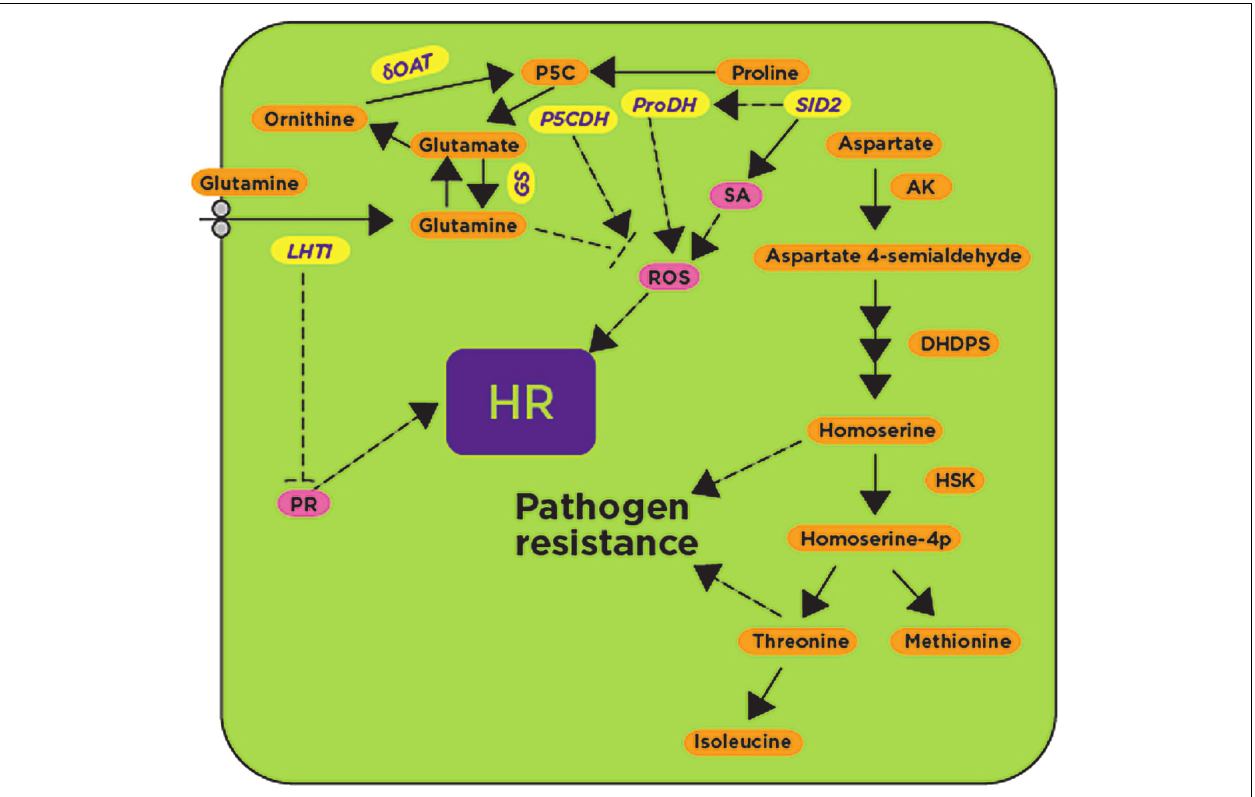
shown in pink) leading to the HR. Accumulation of aspartate-derived metabolites confers pathogen resistance by unknown mechanism(s). SID2, salicylic acid deficient 2 ; P5CDH, δ 1-Pyrroline-5-carboxylate dehydrogenase; ProDH, proline dehydrogenase; δ OAT, δ -ornithine aminotransferase; GS, glutamine synthase; LHT, lysine histidine transporter 1; AK, aspartate kinase; DHDPS, dihydrodipicolinate synthase 2; HSK, homoserine, kinase; HR, hypersensitive response. Dashed lines represent hypothetical regulatory mechanisms with arrows indicating positive regulation, while blunt-ended lines indicate negative